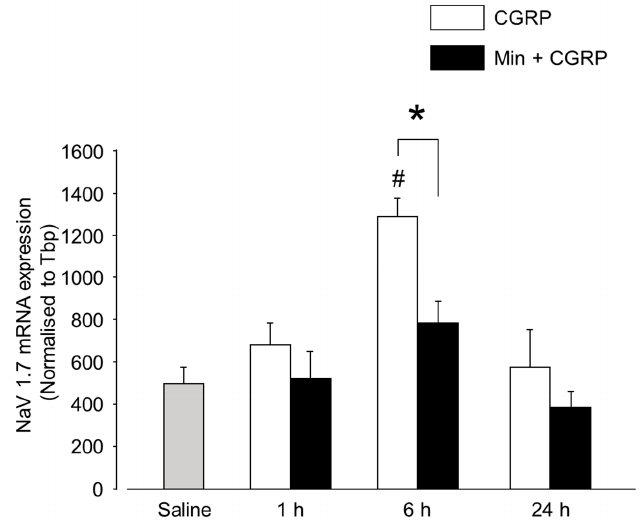
Figure 8. Effect of IG CGRP and Min + CGRP on NaV1.7 expression. CGRP increased the mRNA expression of NaV1.7 after 6 h and Min reduced the CGRP induced upregulation of NaV1.7 expression. *: p < 0.05 with t test and #: p < 0.05 with one-way ANOVA followed by the Dunnett t test for comparison with saline injection. n = 5 rats were assigned to each group.